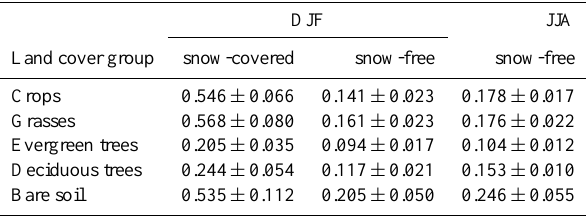
∗ The mean ± one standard deviation surface albedo values are indicated. Values computed from the ensemble of grid cells (at 0.5 ◦ ) with dominant land cover within the area of study (indicated in Fig. 2a).